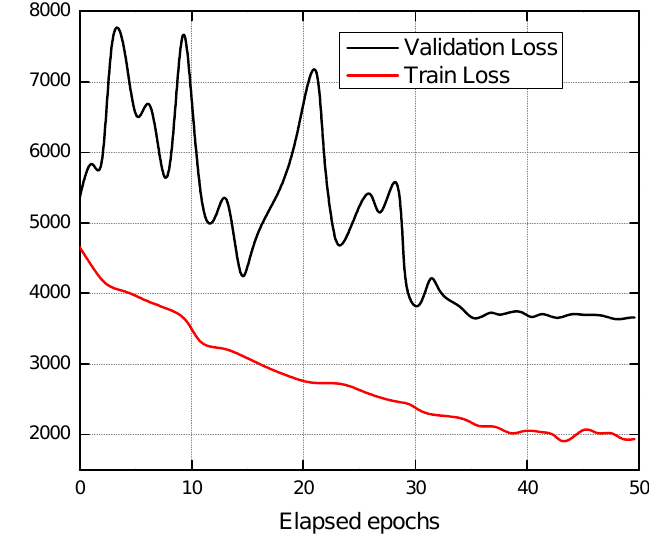
Figure 7. Graph representing the Elapsed epochs Vs Computed loss for the CNN model used In Object